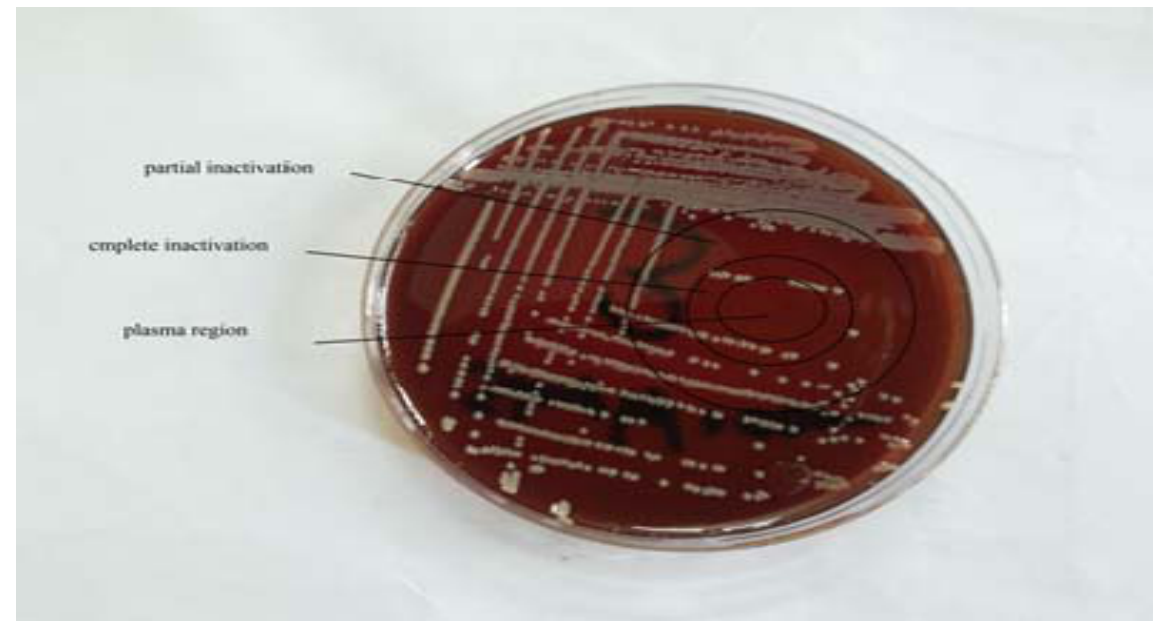
Fig.3: Petri dish with blood agar after the DBD plasma